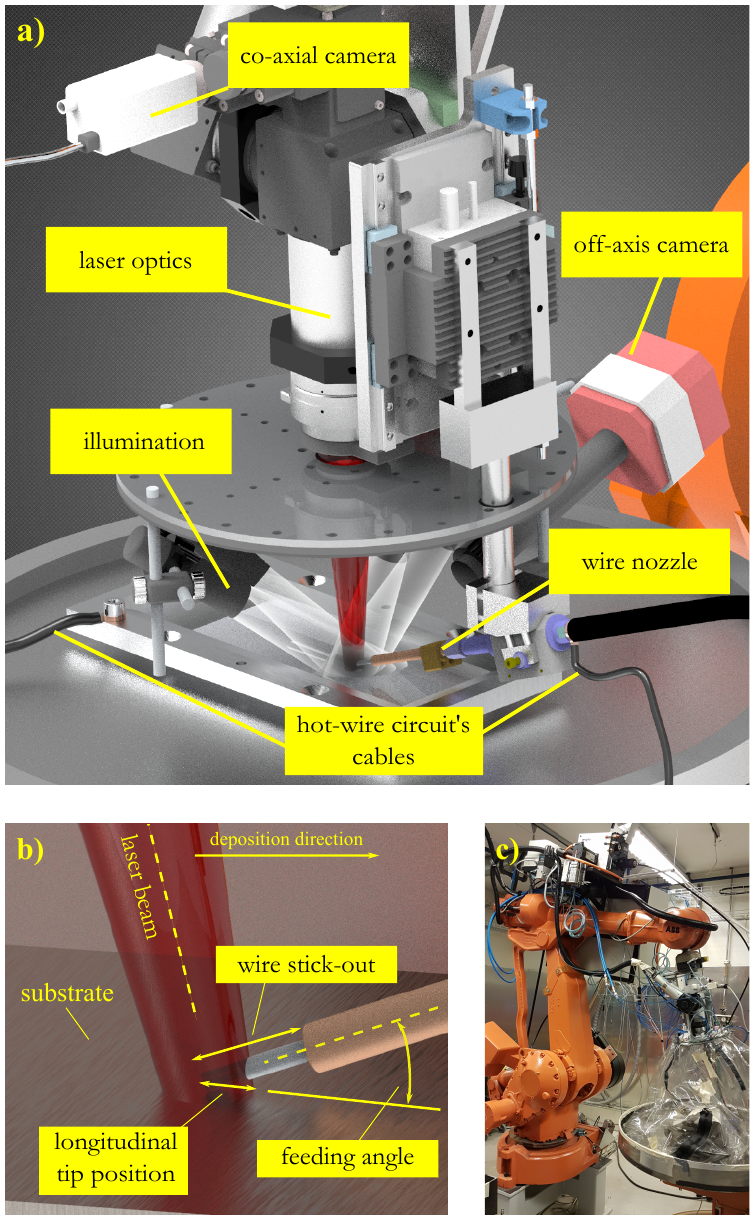
Figure 1. The Hot-Wire Laser-Directed Energy Deposition setup: ( a ) the visualization of the deposi- tion tool, ( b ) the schematic drawing of the feedstock wire tip position relative to the laser beam and the substrate, ( c ) the overview of the